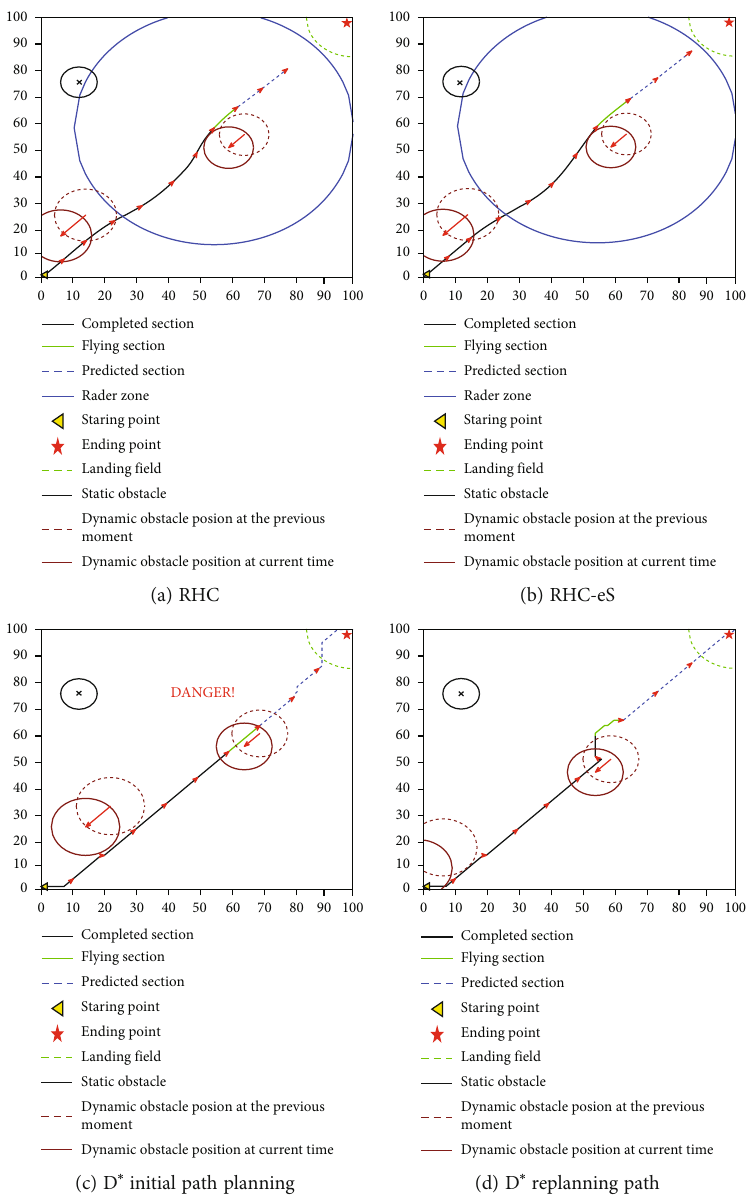
Figure 6: Environmental case 2 path planning